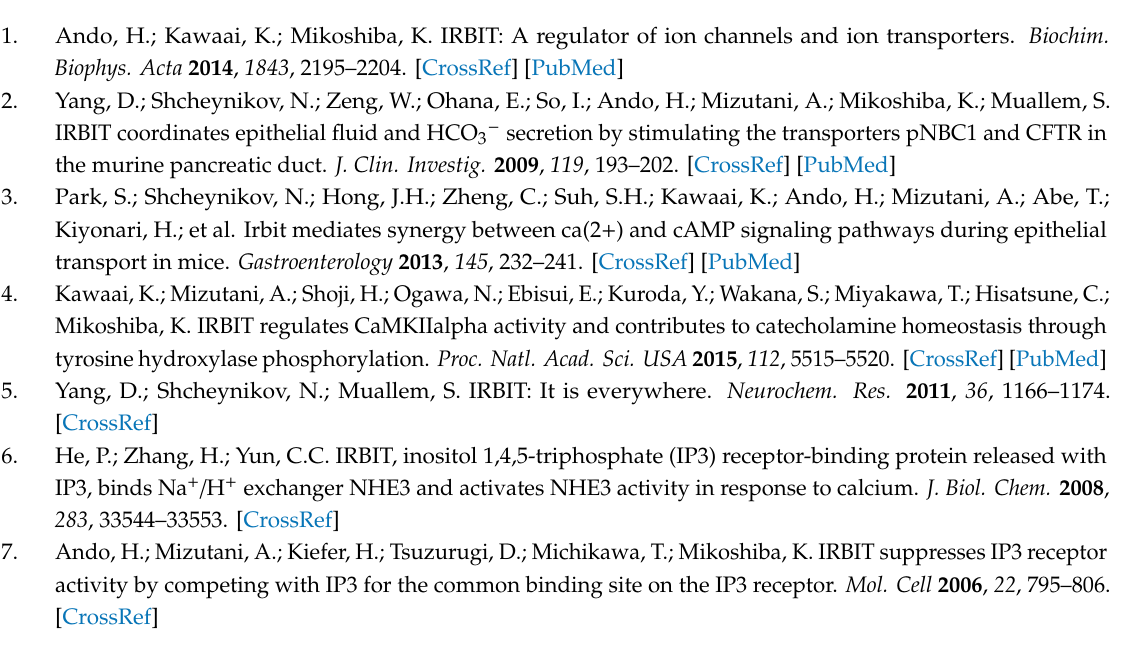
Figure S1: Overexpression of IRBIT plasmids promoted A549 cell migration; Figure S2: IRBIT promoted A549 cell migration in a scratch wound healing assay; Figure S3: Co-expression of IRBIT and NBCn1 increased NBC activity in HEK293T cells; Figure S4: Knockdown of NBCn1 decreased MCF-7 cell motility; Figure S5: Knockdown of IRBIT or NBCn1 was no e ff ect on epithelial to mesenchymal transition (EMT) markers in A549 cells; Figure S6: Overexpression of IRBIT, NBCn1, or co-expression of IRBIT and NBCn1 was no e ff ect on EMT markers in A549 cells; Figure S7: Migratory cellular ability (crystal violet assay) of overexpressed IRBIT or knockdown of IRBIT in presence of EGF stimulation; Figure S8: Inhibited cancer cell migration in presence of CaMKII inhibitor KN93 and NBC inhibitor S0859; Figure S9: Inhibited cancer cell migration in presence of KN62 and